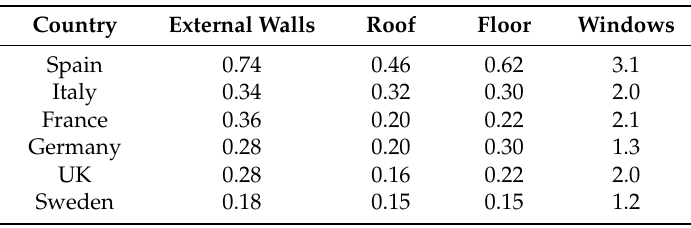
Table 2. Building thermal specifications (U-values in W/m 2 K).